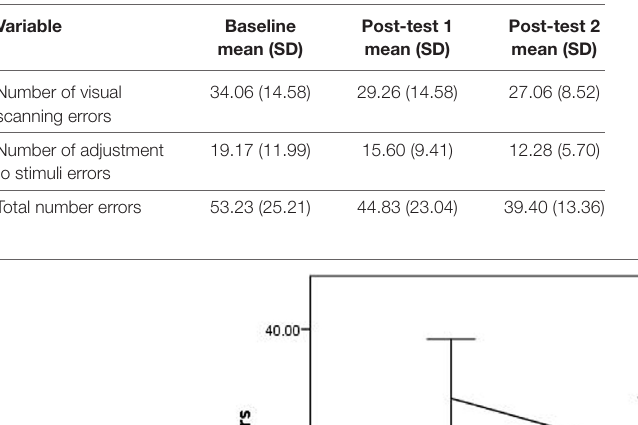
Table 3 | Type and number of errors among baseline, post-test 1, and post-test 2 ( N =